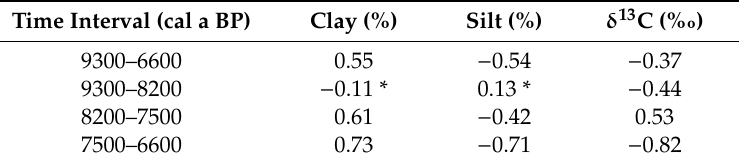
* The p value is greater than